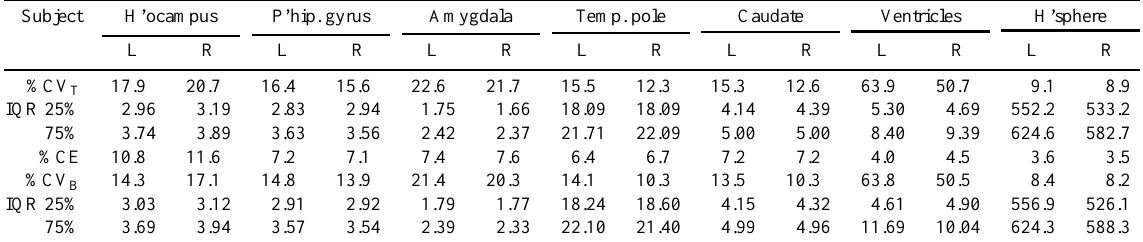
Table 2 Analysis of variance of the volumes of the brain structures for the 29 subjects in Table 1